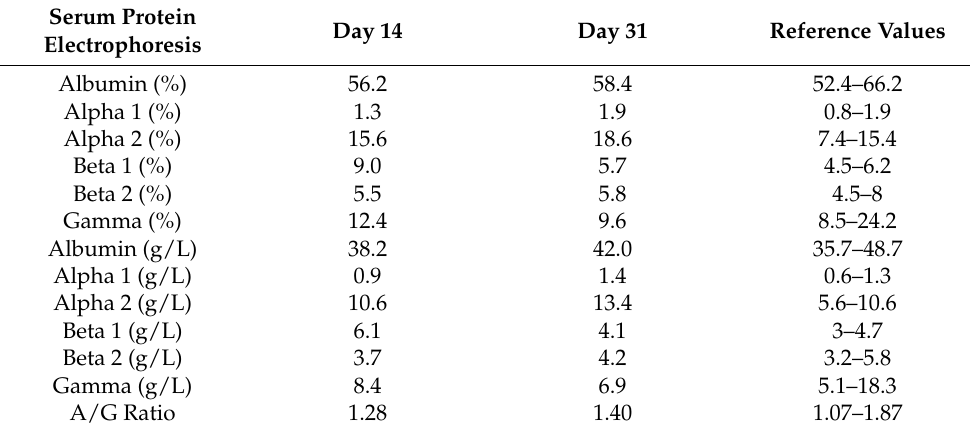
Table 3. Serum protein electrophoresis (Minicap, Sebia Italia S.r.l., Firenze, Italy) on Days 14 and 31, respectively. A mild increase in alpha 2 globulin and beta 1 globulin on Day 14 was reported, consistent with the inflammatory response and the antibodies production.